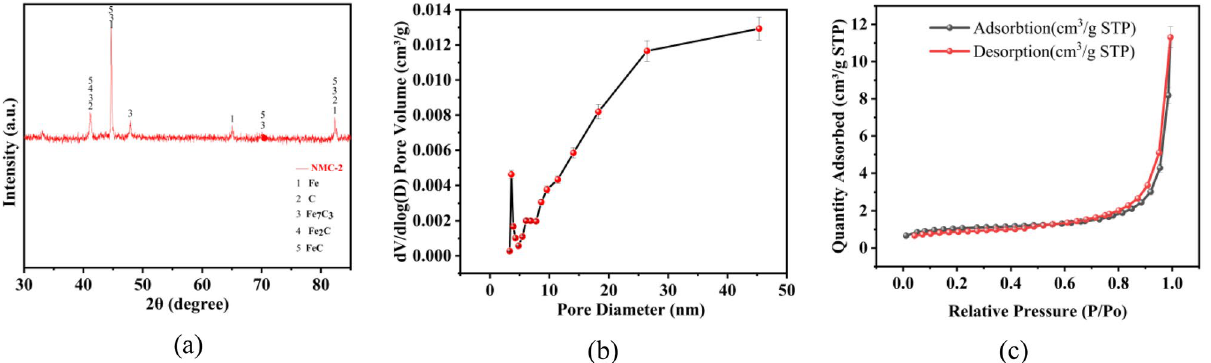
Figure 1. XRD and nitrogen adsorption and desorption tests on materials: ( a ) XRD pattern of NMC-2 adsorbent before adsorption, ( b ) pore size distribution of NMC-2, ( c ) nitrogen adsorption–desorption curve of NMC-2